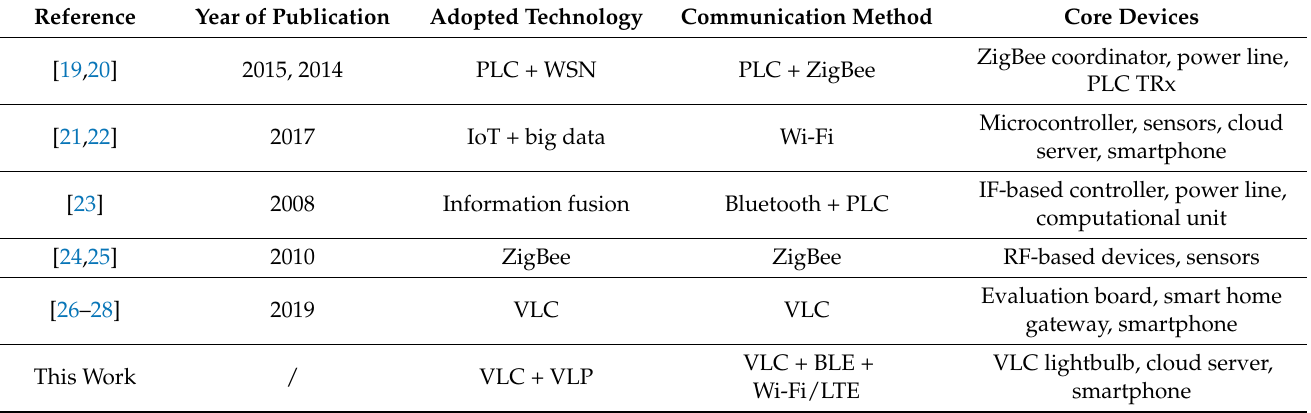
Table 1. Summary of related works on smart control